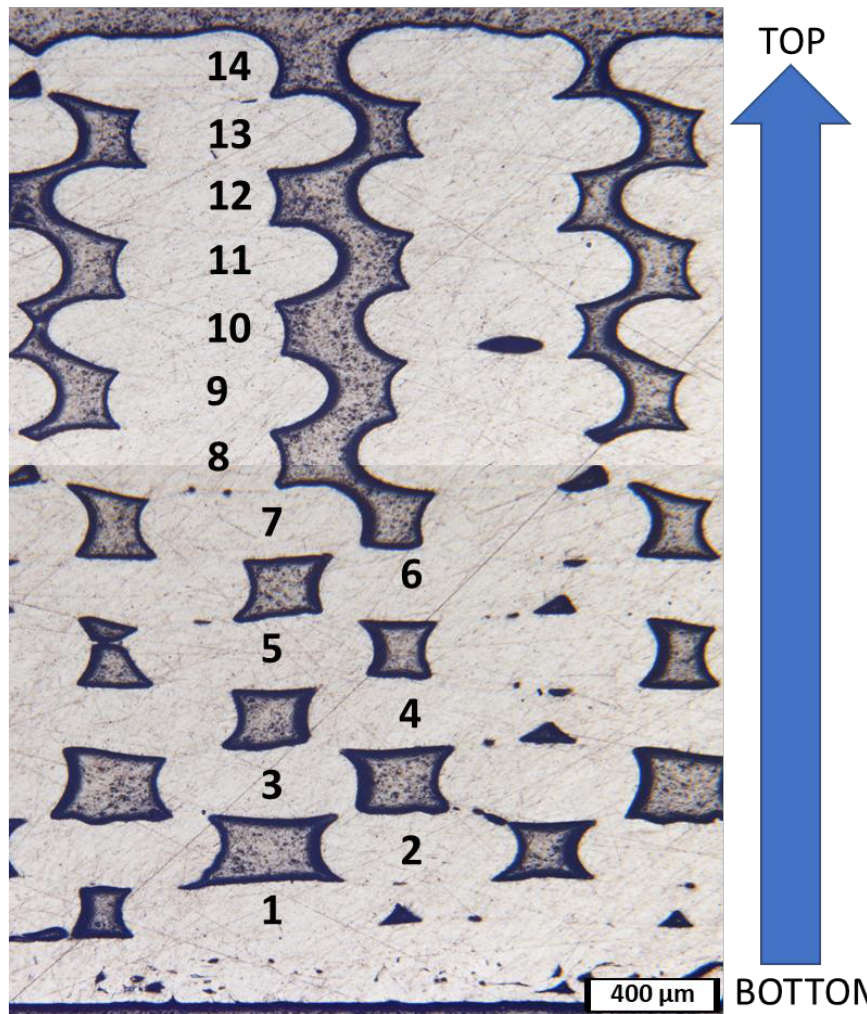
Figure 5. Micrograph of ULTEM 9085 polished cross-section showing all printed layers. Layers are labeled 1 through 14 with 1 being the bottom layer.